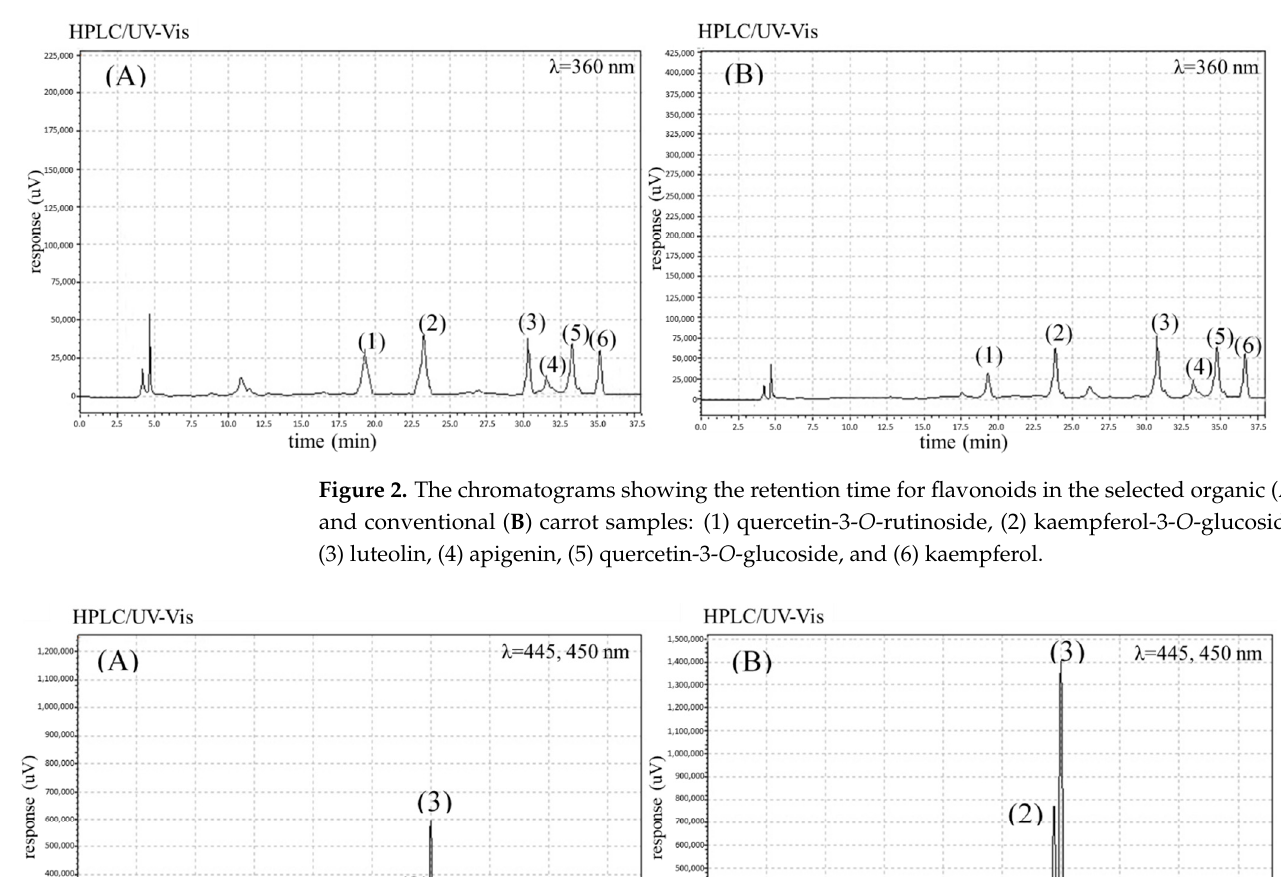
Figure 1. The chromatograms showing the retention time for phenolic acids in the selected organic ( A ) and conventional ( B ) carrot samples: (1) gallic acid, (2) chlorogenic acid, (3) caffeic acid, and (4) p -coumaric acid.